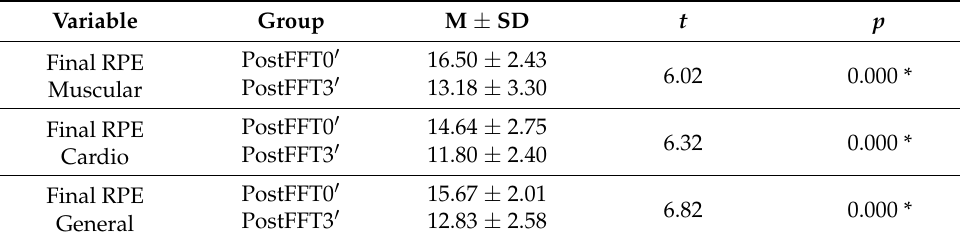
Table 2. Ratings of perceived exertion recorded in the FFT workout.